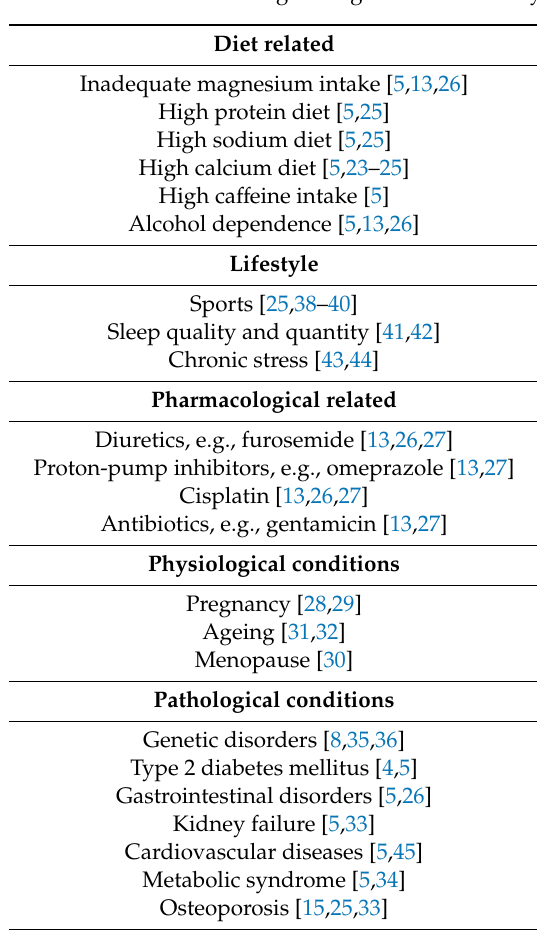
Table 2. Factors contributing to magnesium